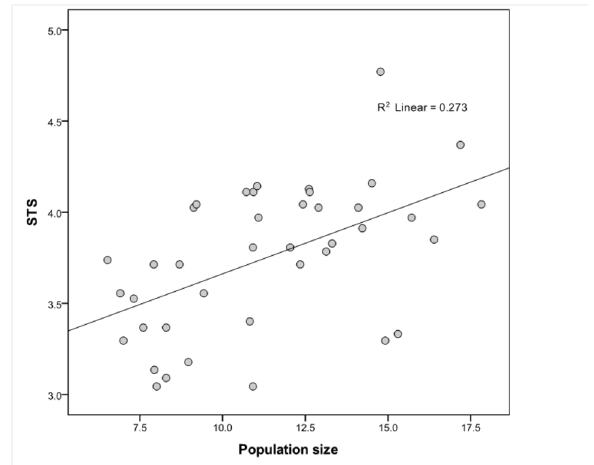
Figure 1. Scatter plot showing that total number of subsistants (STS) is influenced by population size in a sample of 40 small-scale food-producing groups. Both STS and population size are